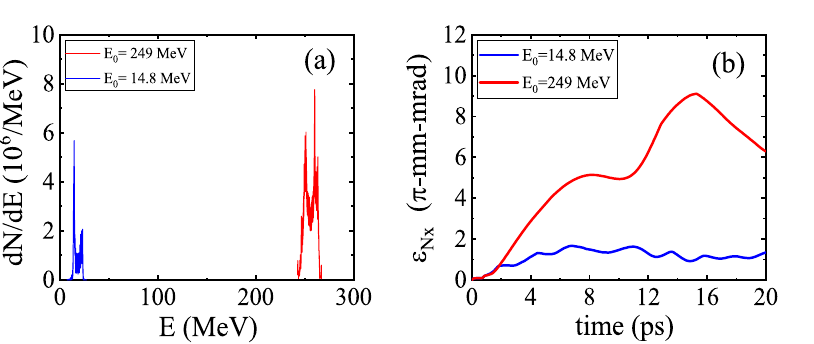
Figure 9. (a) Final energy spectra of beam electrons after 17 ps of acceleration, and (b) variation of the bunch emittance ǫ N,x as a function of the propagation time, for two different initial energies: E 0 E 0 = 249 MeV .